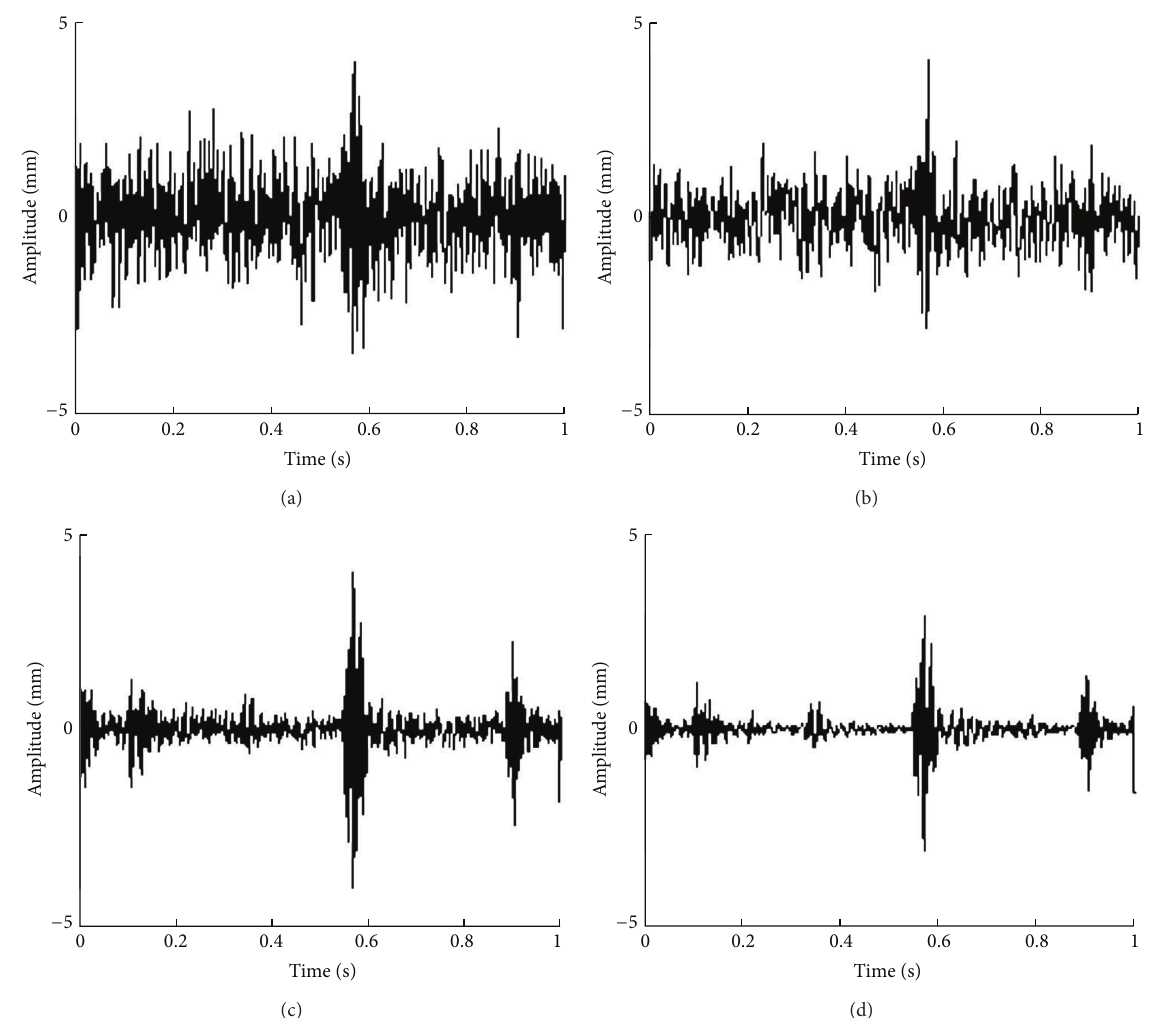
Figure 5: Comparison of denoising results obtained by the optimal filter, the morphological filter of flat SE, and the wavelet of Morlet, for the vibration signal of a roller bearing with an outer-race fault: (a) the original signal, (b) the wavelet of Morlet, (c) the morphological filter of flat SE, and (d) the optimal filter.